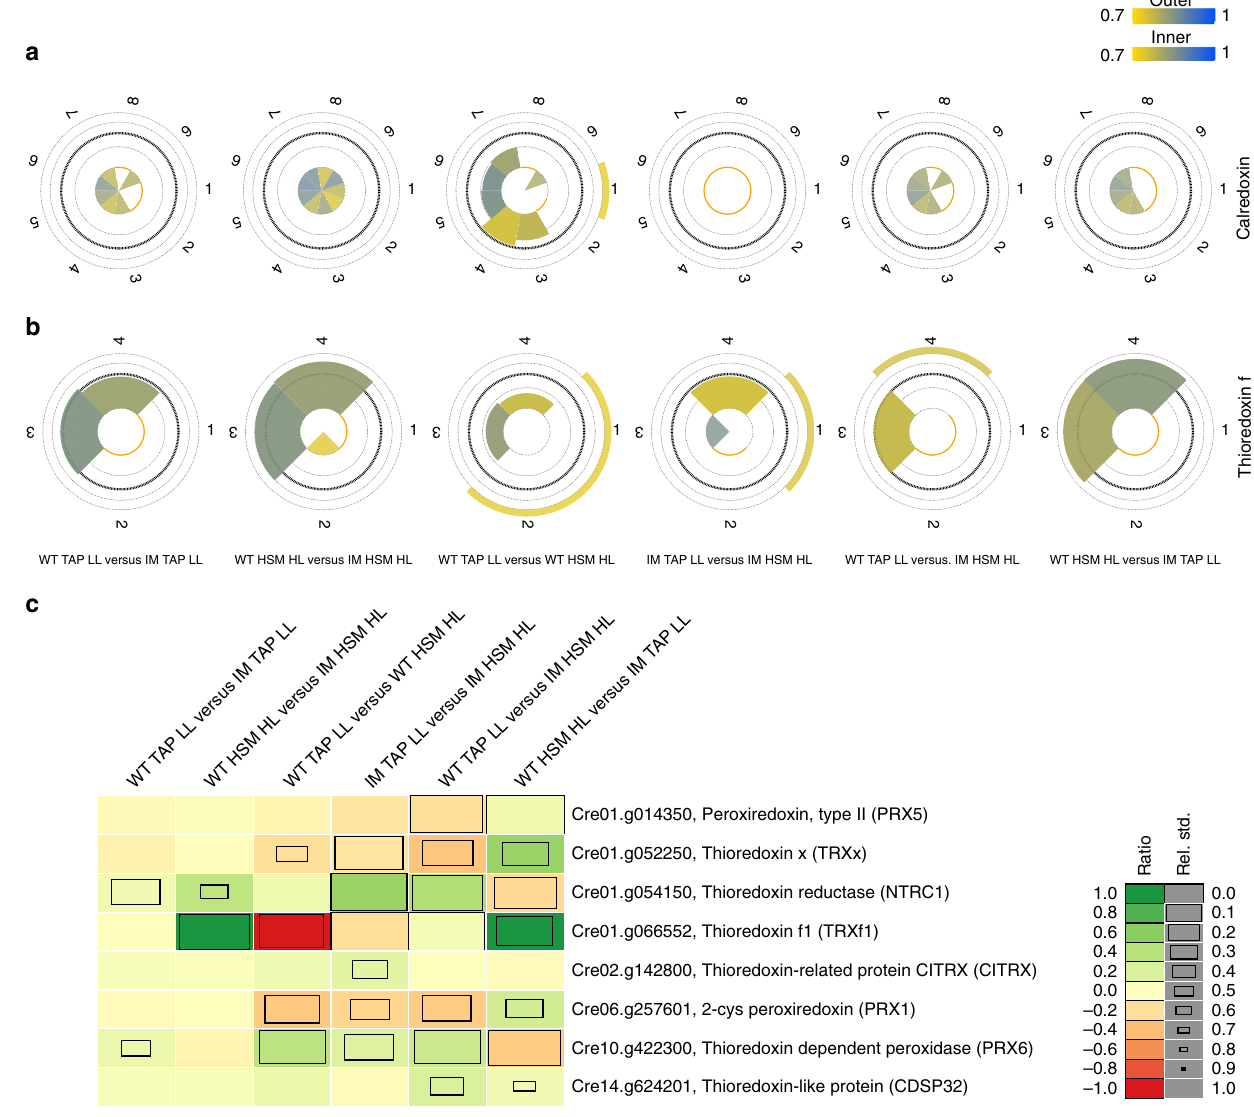
Figure 6 | TRX f is diminished in HL on depletion of CRX. MS-based 15 N metabolic labelling-based quantitation from CRX (Cre03.g202950.t1.1) ( a ) and TRX f (Cre01.g066552.t1.1) ( b ). Each pie slice represents a quantified peptide. The area of a pie slice is proportional to the log2 ratio of the corresponding peptide between the indicated conditions. Colours represent pyQms quantification score; 0.7 (yellow, false discovery rate (FDR) r 1%) to 1 (blue, prefect match). ( c ) Selected knowledge based TRX community. The heat map represents the ratios of the proteins ranges from yellow to green indicating an upregulation and from yellow to red indicating a downregulation. The s.d. is visualized by the size of the box, smaller the box higher the s.d. of the protein ratio (see legend). For quantitative MS analysis, 14 N-/ 15 N-labelled WTand 15 N-/ 14 N-labelled IM crx were mixed based on equal protein amount (total protein amount 100 m g). Eight different conditions were examined as followed: (1) 14 N-labelled WT TAP LL versus 15 N-labelled IM TAP LL, (2) 15 N-labelled WT TAP LLversus 14 N-labelled IM TAP LL, (3) 14 N-labelled WT HSM HL versus 15 N-labelled IM HSM HL, (4) 15 N-labelled WT HSM HLversus 14 (7) 14 N-labelled WT TAP LL versus 15 N-labelled IM HSM HL and (8) 14 N-labelled IM TAP LL versus 15 N-labelled WT HSM